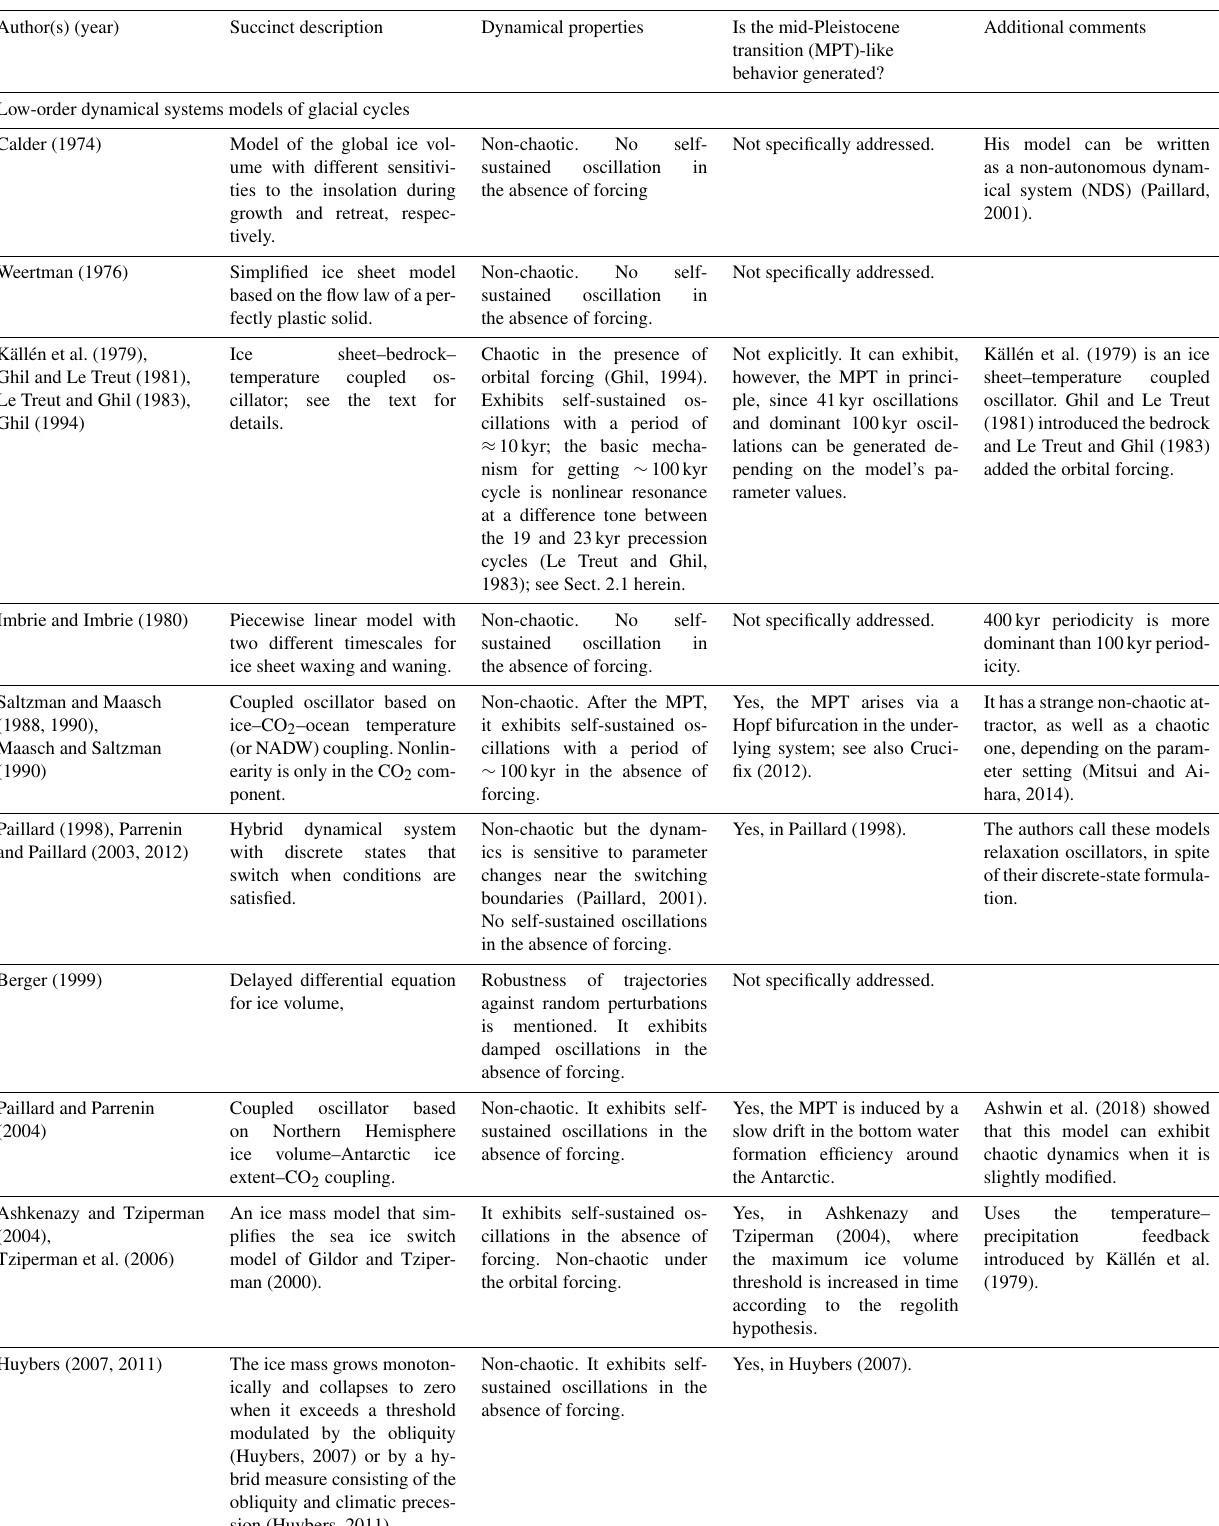
Table A1. List of simple conceptual glacial-cycle models with only 1–3 variables. Note that, while extensive, this list is not